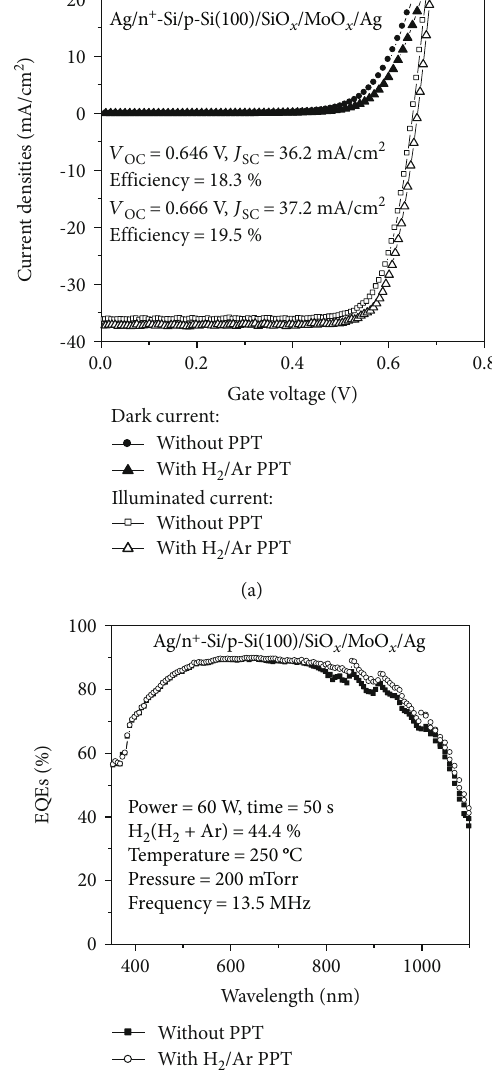
/Ar PPT. (b) 2 /Ar 2